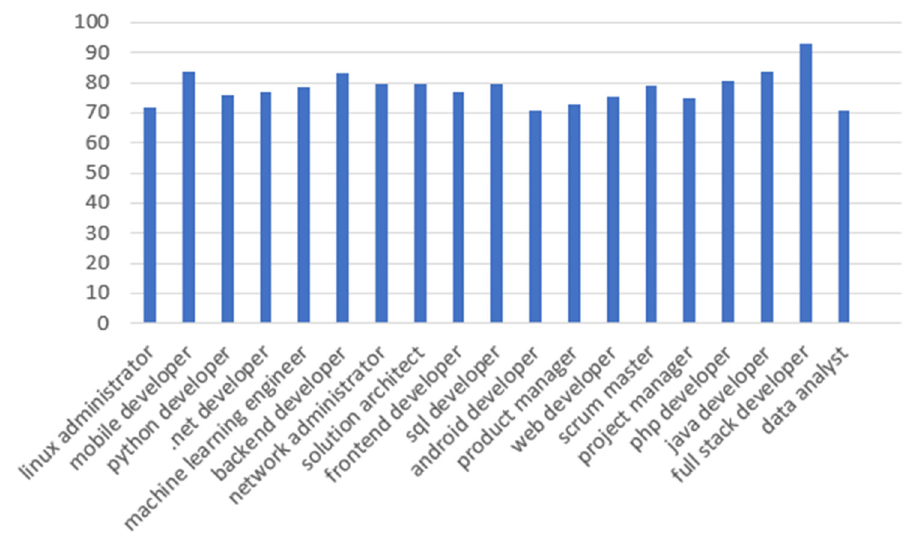
Figure 20. Success rate of finding job requirements in individual job positions—machine learning with improved marking lists approach. Table 6. Comparison of individual